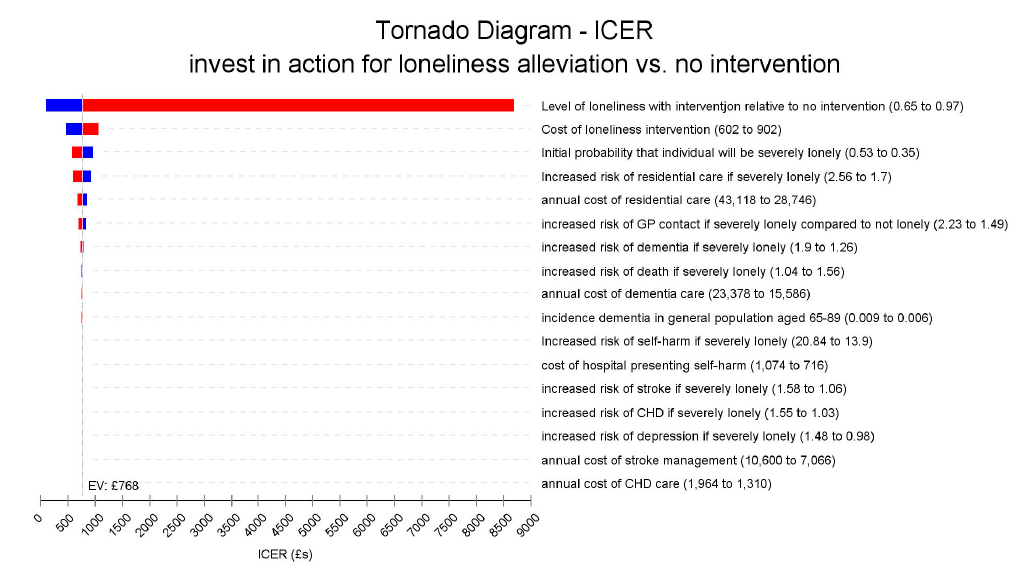
Figure 2. Tornado diagram of the univariate sensitivity analyses.